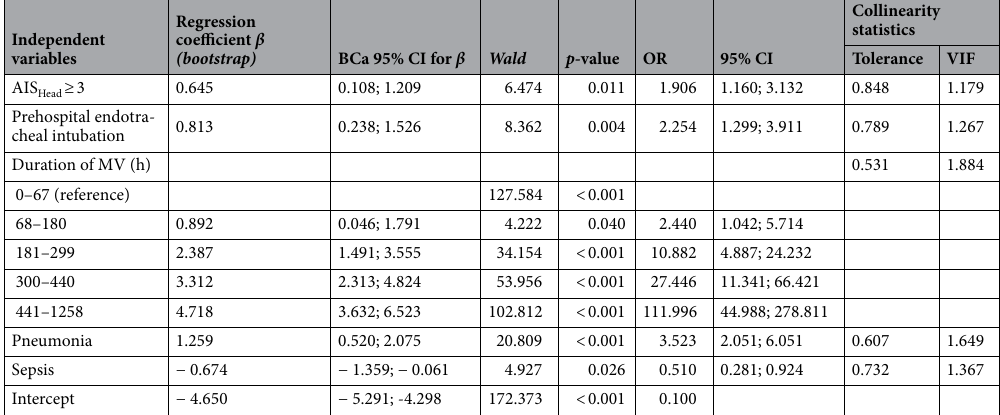
Table 4. The T 3 P-Score (model B) for prediction of tracheostomy in thoracic trauma patients. Nagelkerke’s R 2 was 0.601, ROC AUC was 0.938, 95% CI [0.920, 0.956] ( p < 0.001), the Hosmer–Lemeshow-test was not statistically significant ( χ 2 = 6.998, df = 7, p = 0.429), the omnibus test was statistically significant ( χ 2 = 443.948, df = 8, p < 0.001).